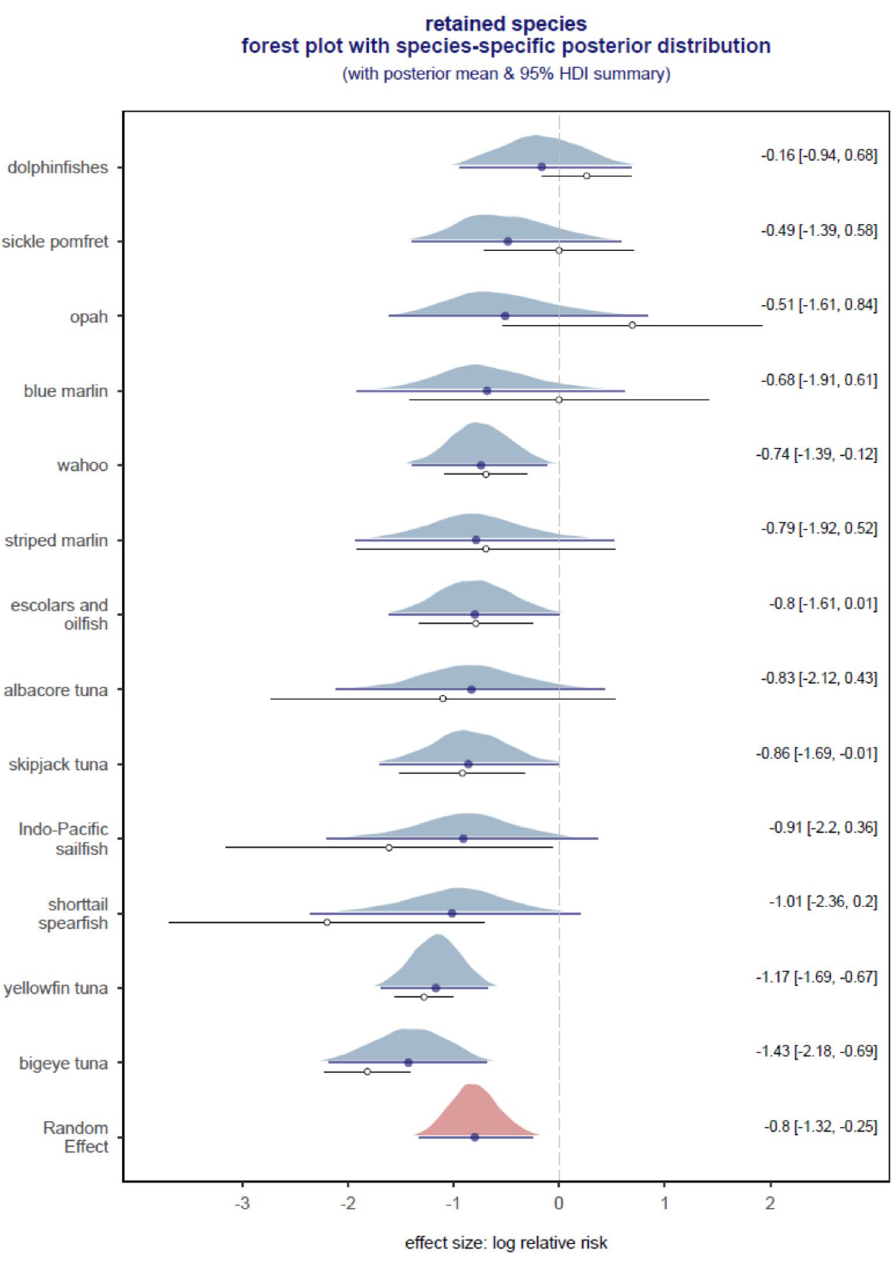
Figure 3. Model-predicted log relative risk ratio derived for 13 species-specific effect sizes for retained species. Shrinkage estimates were derived using a precision weighted Bayesian random-effects meta-analytic model with Gaussian likelihood. Polygon = density of the posterior draws (the effective sample size = 10,000) and the horizontal line underneath each polygon = 95% highest posterior density interval (HDI) of the posterior draws, solid dot = mean of the posterior draws shrunk towards the pooled or Random Effect, which is the mean or overall expected log relative risk ratio for all 13 species (right-side labels = the posterior mean and HDI summaries). Below the density polygon is an open dot = observed effect size and thin horizontal line = observed effect size ± 1 standard deviation derived using the metafor::escalc() function. The difference between solid and open dots reflects the degree of shrinkage that is dependent on sample